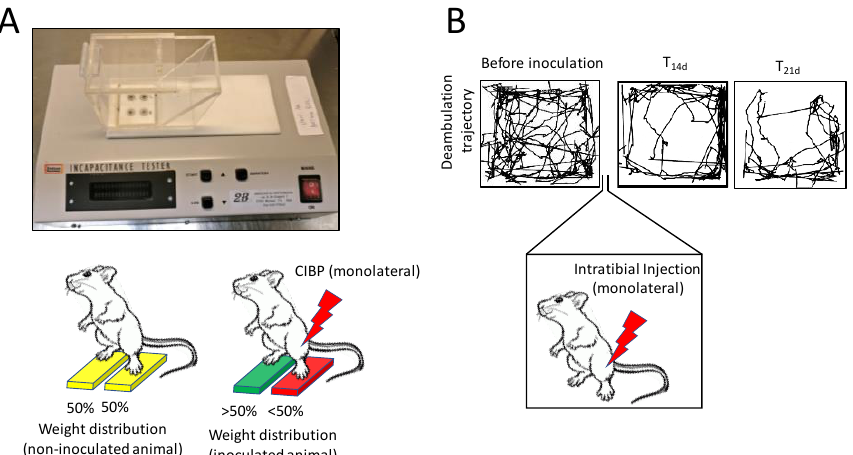
Figure 3. In vivo, noninvasive methods to evaluate cancer-induced bone pain (CIBP). ( A ) Incapacitance tester: cancer cells are intratibially injected monolaterally, and after an experiment-specific timeframe the animal is placed on an incapacitance tester. This is a device which features 2 scales, that are able to discriminate weight distribution between the 2 hindlimbs, when the animal is stood up at an incline (as visible from A, upper panel). In normal conditions, rodents will tend to distribute the weight evenly between the 2 limbs, but when one of them experiences CIBP, mice will relieve them from some of their body weight, reducing the % of weight bore by that limb. ( B ) Spontaneous deambulation test: mice are acclimated in a 45 × 45 × 45 cm arena 3 times the week before the cancer cells inoculation to establish a baseline. On the third test, the trajectory of the mouse is recorded and quantified over a specific timeframe (e.g., 10 min), to assess the distance the mouse is willing to walk voluntarily, without external stimulation. Cancer cells are then injected monolaterally (e.g., intratibially) and after an appropriate time (e.g., T 14 and T 21 days), mice will start showing a decrease in spontaneous ambulation, which is mostly due to CIBP. It is also possible to review the mouse behaviour to assess rearing behaviour and limb usage if a video recording device is used for the